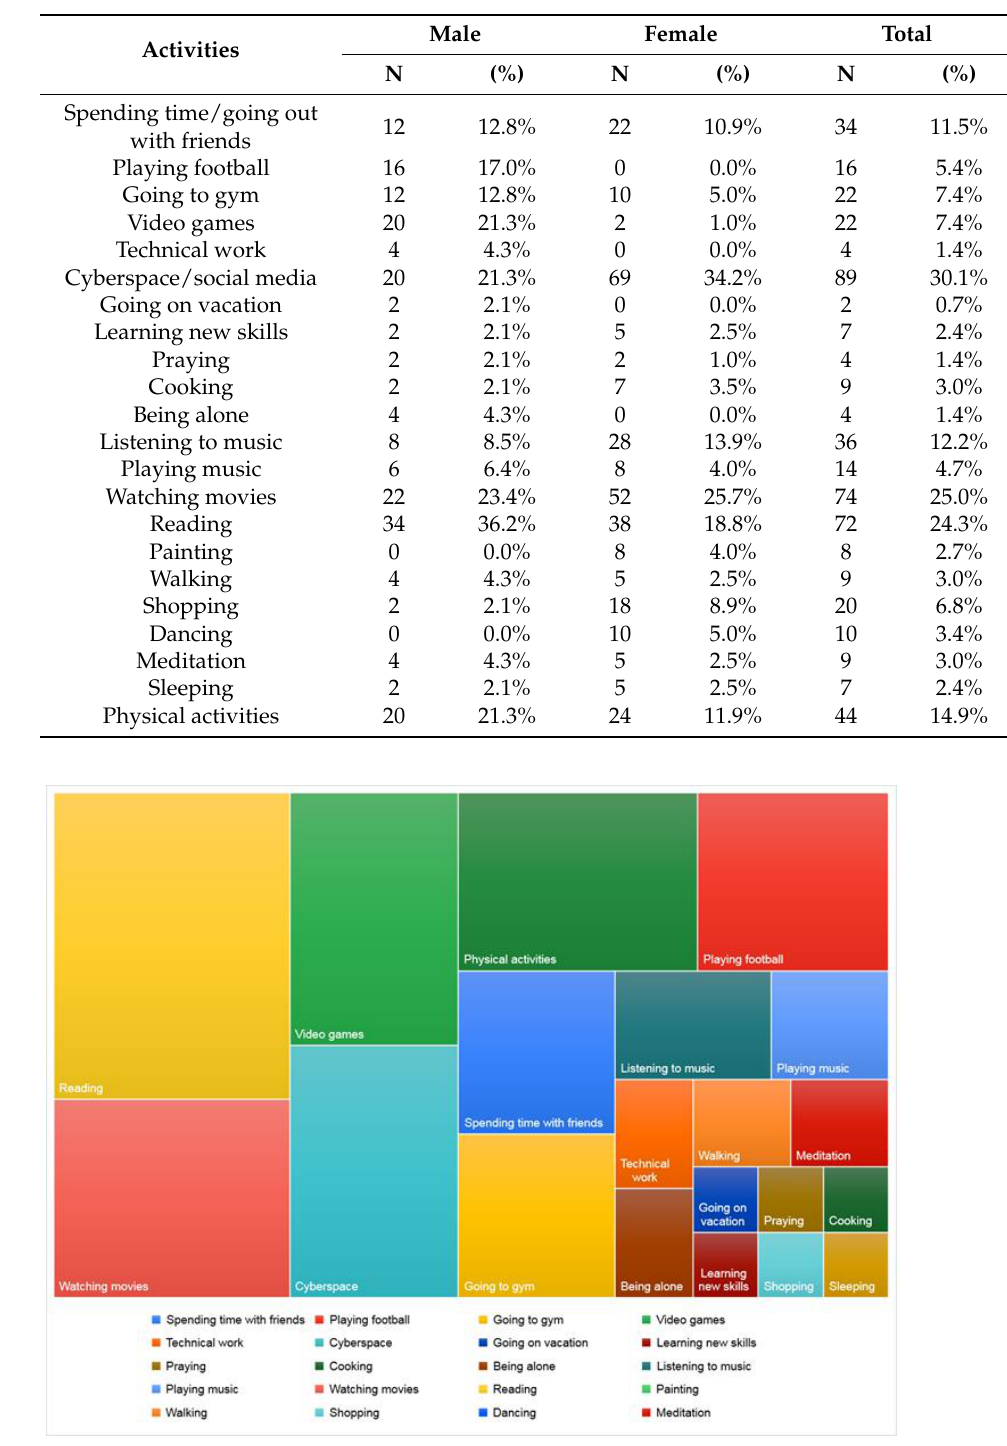
Figure 1. Current self-care activities performed by male participants.